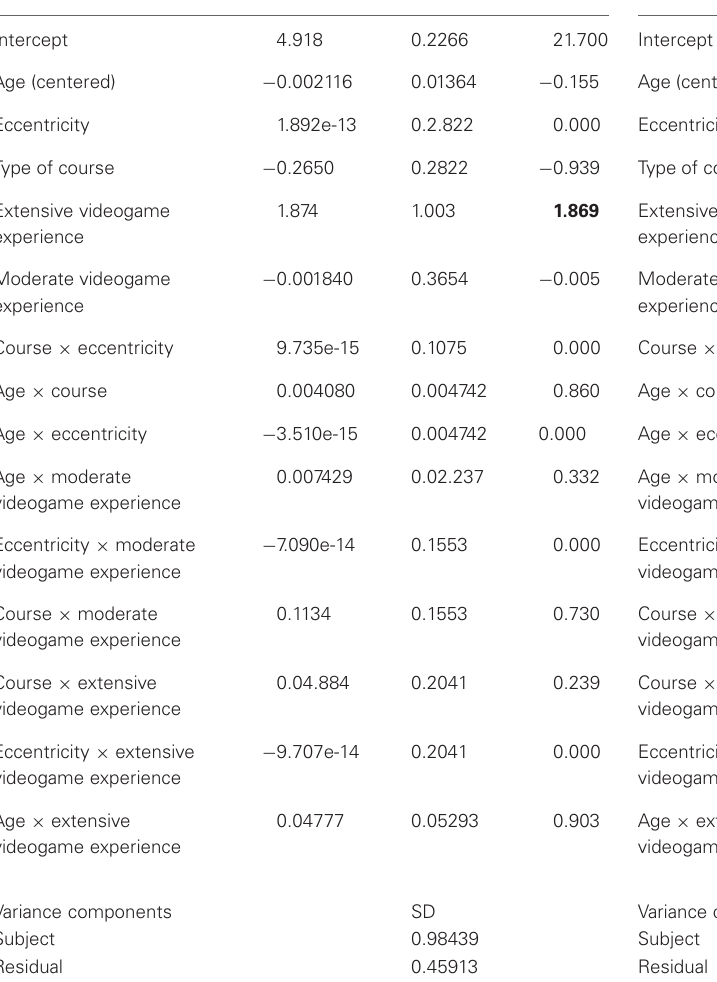
Table 6 | Linear mixed model for mean saccadic amplitude (in bold significant effects with t -value ± 2).